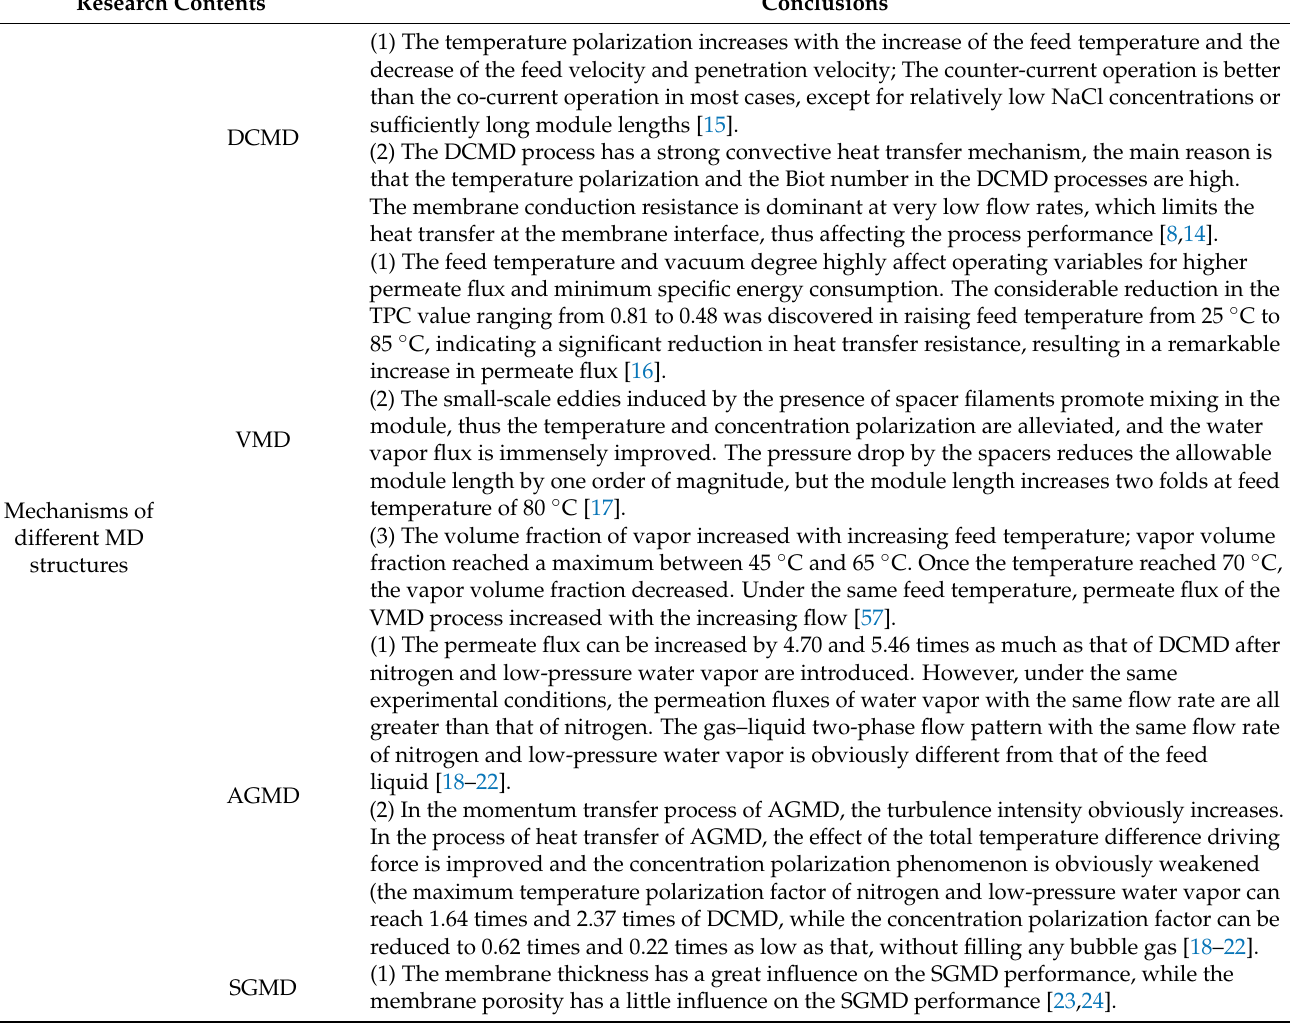
Table 1. Research topics and